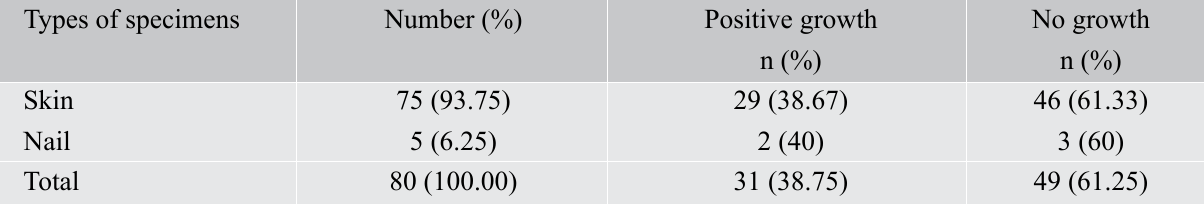
Table I: Isolation rate of dermatophytes from skin and nail samples (n=80) Types of